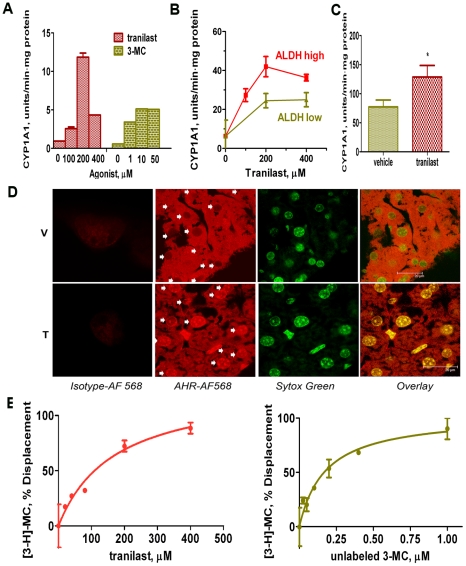
Tranilast is an AHR agonist.A. CYP1A1 induction (EROD assay) by tranilast or 3-MC (a high affinity AHR agonist). Adherent MDA-MB-231-derived D-CSCs were pre-treated for 1 h with either tranilast or 3-MC and then assayed for CYP1A1 expression by EROD assay. The enzyme activity was measured as the product-related fluorescence and expressed as arbitrary fluorescence units per min per mg protein. Tranilast induced CYP1A1 expression at higher concentrations than 3-MC, but generated higher maximum levels of the enzyme. B. ALDH high and ALDH low MDA-MB-231 cells, previously sorted by FACS, were allowed to adhere and treated as above. Higher levels of induced CYP1A1 expression were observed in the ALDH high cells. C. C57BL/6 mice were treated with tranilast twice (300 mg/kg; d 0 and d 1) and terminated on day 2 to recover liver tissue. CYP1A1 (EROD assay) was measured in liver microsomal fraction from tranilast- or vehicle-treated mice. Tranilast induced a significant increase in CYP1A1 enzyme activity (p<0.05; n = 5/group), indicating that sufficient drug levels were achieved to exert AHR agonist activity in vivo. D. Mice were treated with tranilast (T) or vehicle (V) as in Fig. 6C. Tranilast-induced nuclear translocation of AHR in vivo as detected by immunofluorescent confocal microscopy, further confirming its AHR agonist activity in vivo. Cryo-sections of liver from tranilast- or vehicle-treated C57 mice were stained against AHR (AF 568, red) and counter-stained with a nuclear-specific stain Sytox Green (green). The arrows indicate the nuclei. The images are representative of each group (n = 5/group). E. Competition of tranilast or unlabeled 3-MC with [3-H]-3-MC for binding to plate-immobilized AHR from mouse liver cytosol. The data was acquired in duplicate and is expressed as a % displacement of radioactive ligand. Ki = 44 µM for tranilast versus 0.035 µM for the non-labeled 3-MC.